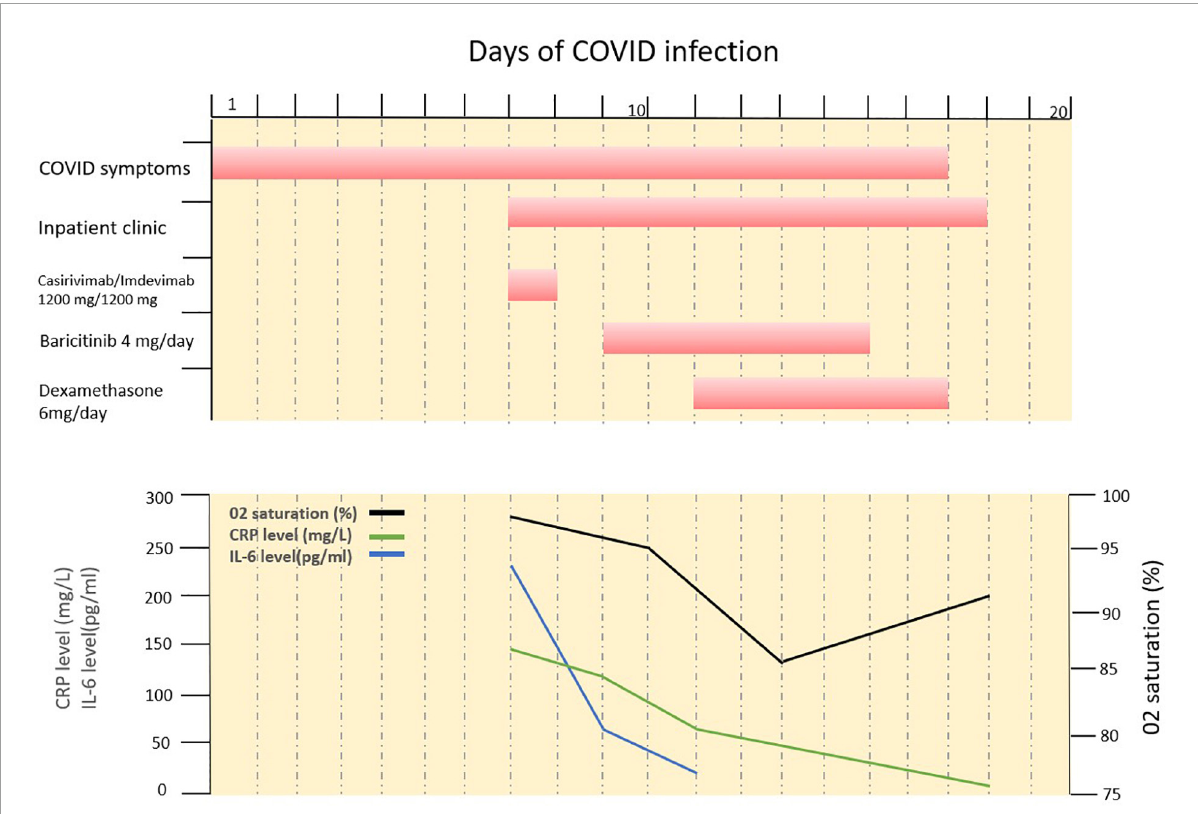
FIGURE2 Time course of COVID symptoms and treatments, inflammation levels and peripheral oxygenation during COVID-19 infection. Day 0, COVID-19 symptoms started; Day 7, inpatient clinic + Casivirimab-imdevimab treatment; Day 9, transferred to COVID clinic-Baricitinib 4 mg added; Day 11, steroid treatment added; Day 18,